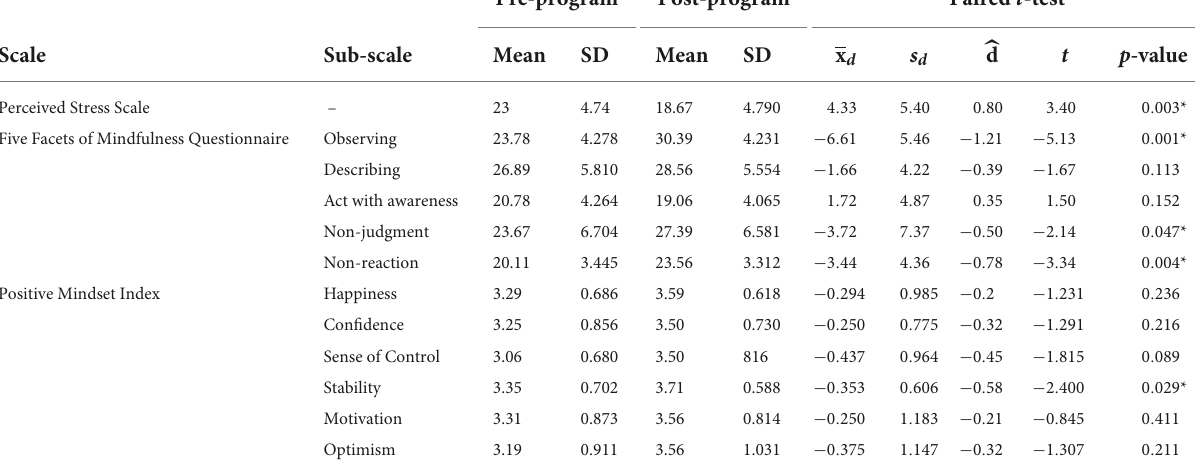
TABLE 5 Paired-sample t -tests for the PSS and FFMQ summary.